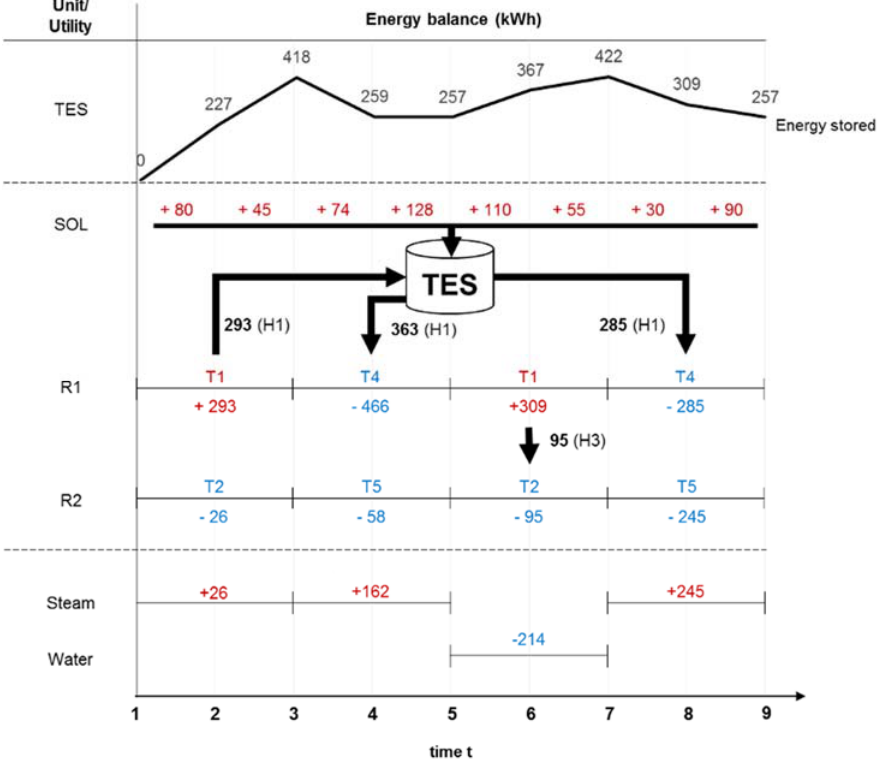
Figure 6. Energy profile for scenario (b).